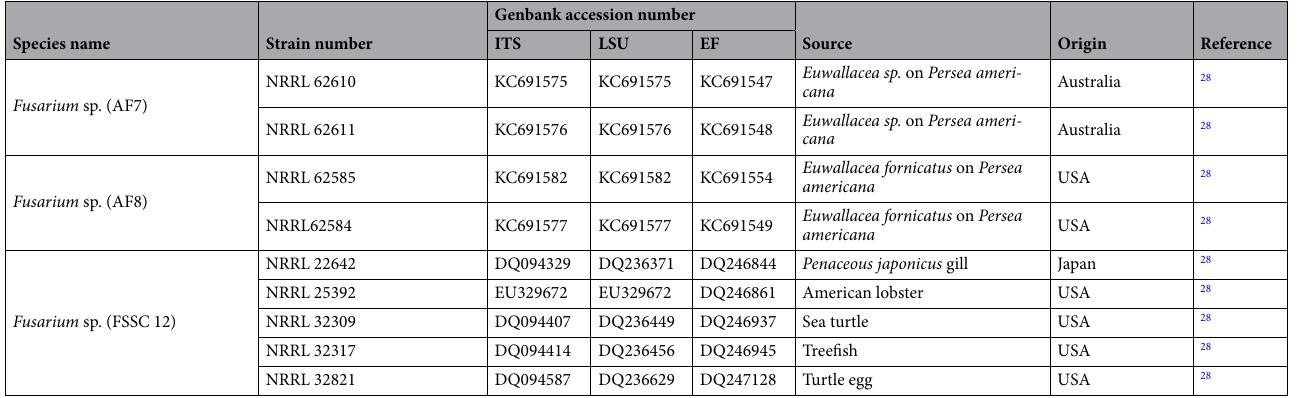
Table 2. Fusarium strains included in the phylogenetic